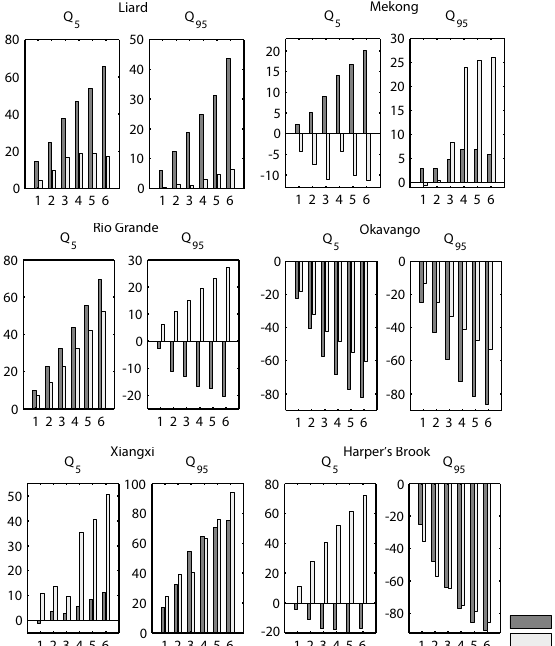
Fig. 7. Percentage change from baseline in GHM- and CHM- simulated Q5 and Q95 monthly runoff (vertical axis) with UKMO HadCM3 prescribed warming of 1–6 ◦ C (horizontal axis), for each catchment.